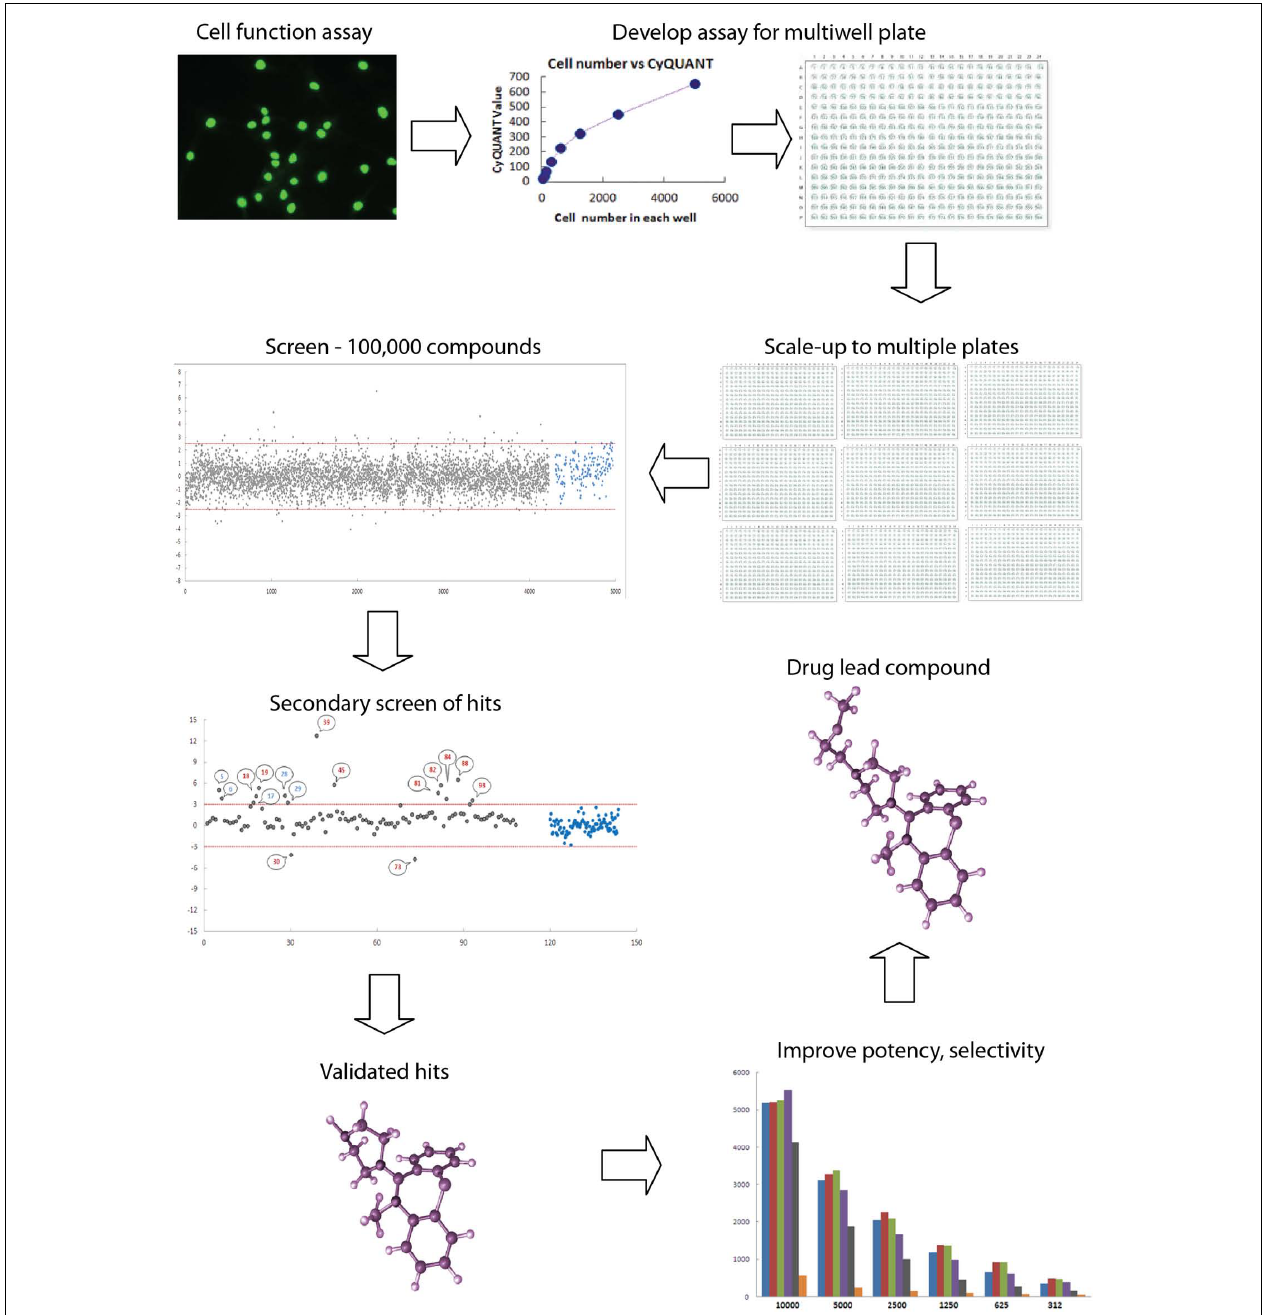
FIGURE 1 | High throughput screening: industrial scale biology. High throughput screening is an automated process for conducting thousands of assays to identify active molecules modulating a biomolecular activity. Assays are performed in multiwell plates with robotics for cell and liquid handling and other aspects such as moving plates from incubator to drug delivery to plate reader. An assay for a cell function of interest must be validated for multiwell plate readers, such as fluorescence, absorbance, or luminescence. Here the assay is a fluorescence assay (Cyquant) for cell number. High levels of quality assurance and quality control are required to reduce the variance of the measurement so that the assay can be reliably scaled to multiple plates. Typically, thousands of compounds are screened for activity, with “hits” being defined as those compounds whose activity on the assay falls outside three